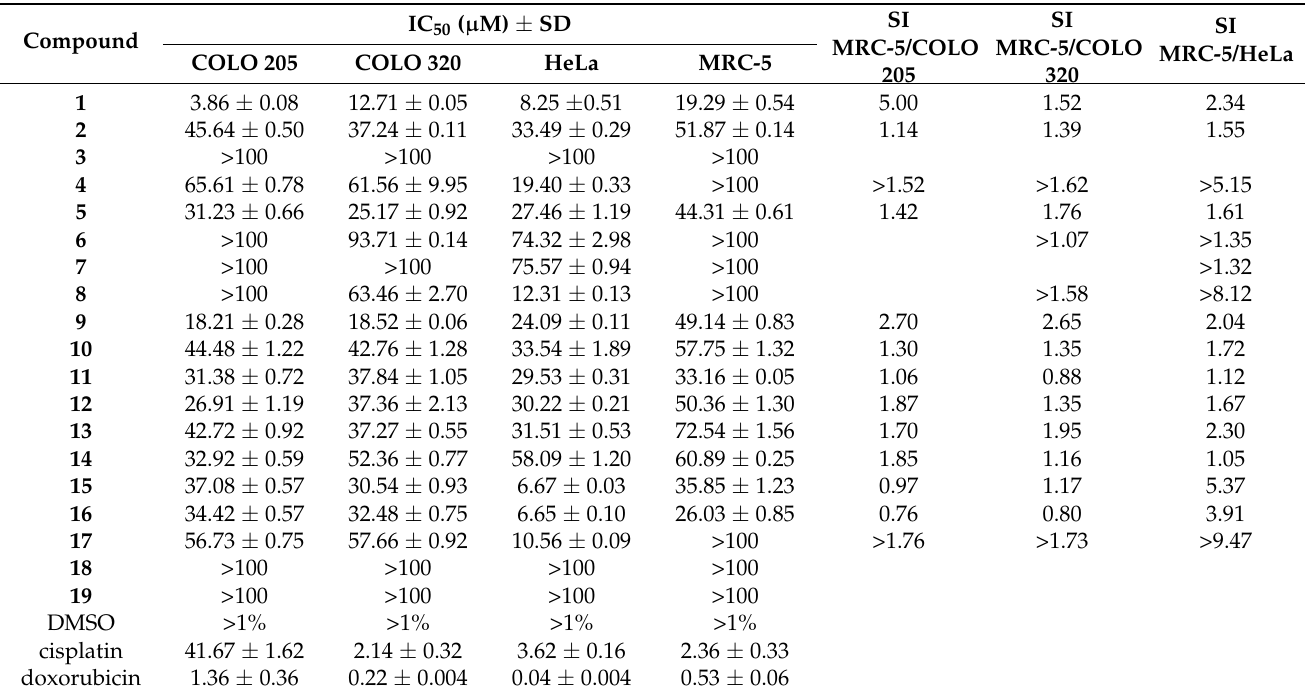
Table 6. Antiproliferative activity (IC 50 values) of the isolated compounds ( 1 – 19 ) (SI is the selectivity index).